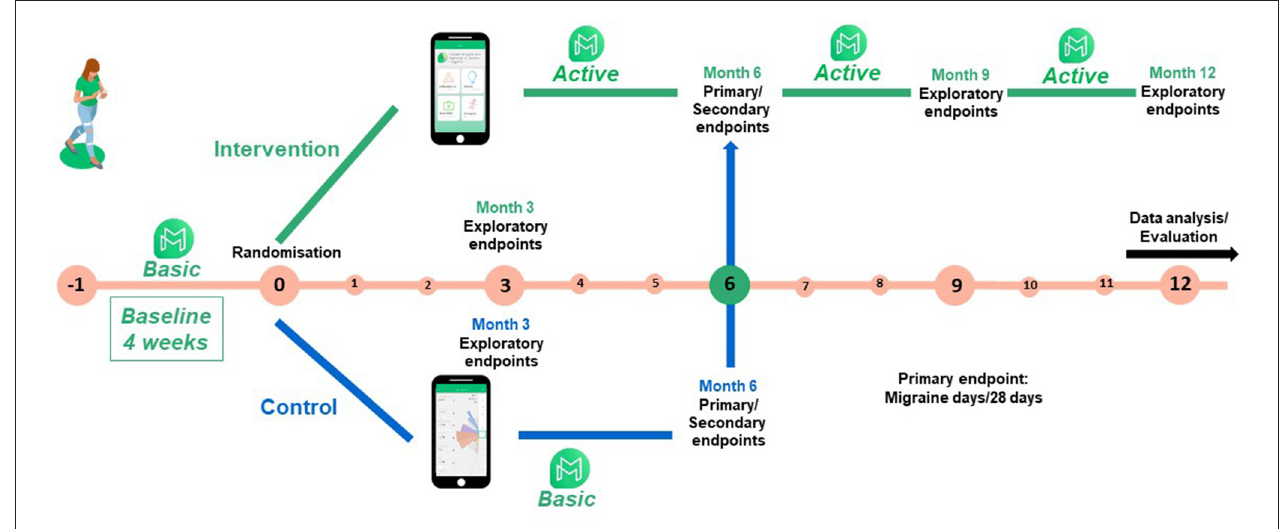
FIGURE 1 | SMARTGEM’s study flow.